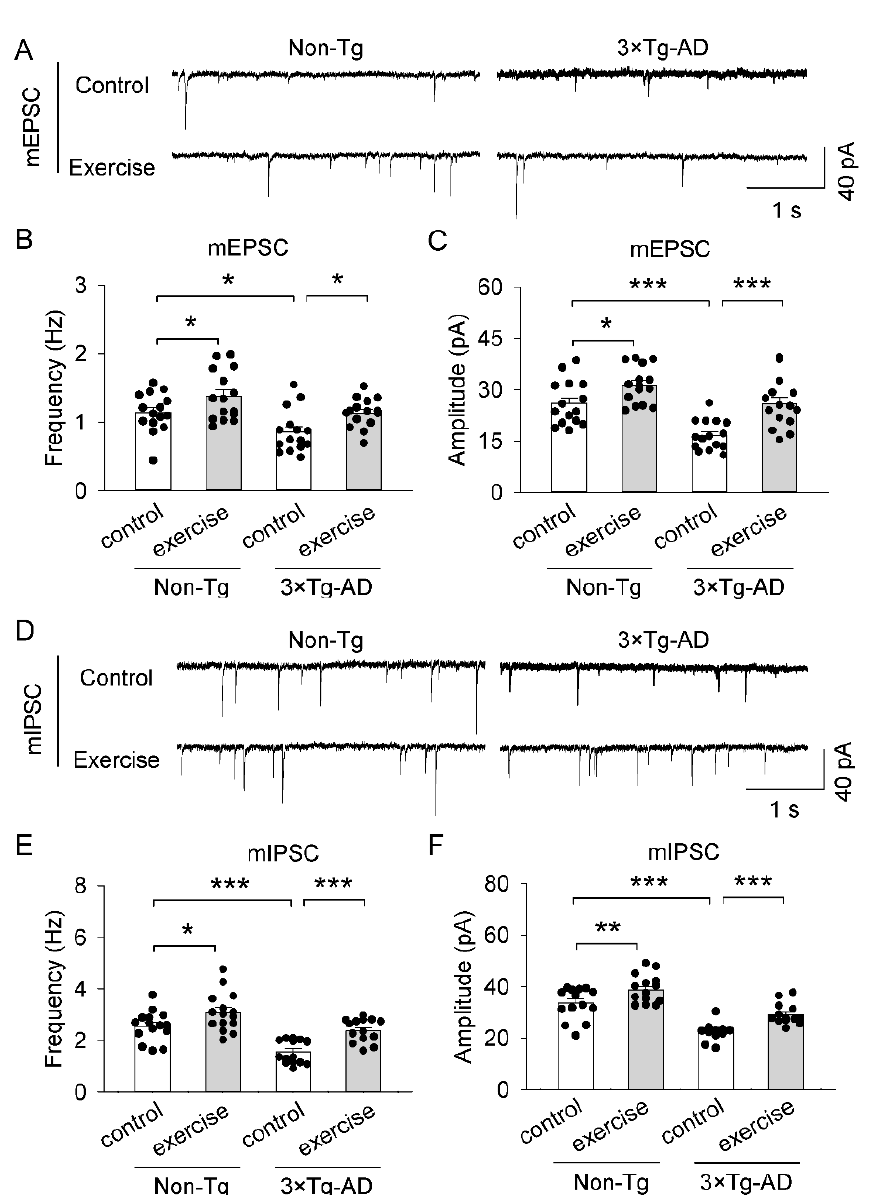
Figure 5. Treadmill exercise blocked the reduction of synaptic transmission of 3 × Tg-AD Mice. ( A , D ) Representative mEPSCs ( A ) and mIPSCs ( D ) were recorded from prefrontal cortex pyramidal neurons in slices prepared from the non-Tg control group, non-Tg exercise group, 3 × Tg-AD control group, 3 × Tg-AD exercise group mice. ( B , C ) The mean frequency ( B ) and amplitude ( C ) of mEPSCs in the prefrontal cortex in these four groups of mice. The mean frequency (* p = 0.014, n = 15-15 and amplitude (*** p < 0.001, n = 15-15) of mEPSCs were significantly decreased in the 3 × Tg-AD mice compared to the non-Tg control group, and these decreases were attenuated by treadmill exercise pretreatment (frequency, * p = 0.012, n = 15-15; amplitude, *** p < 0.001, n = 15-15). ( E , F ) The mean frequency ( E ) and amplitude ( F ) of mIPSCs in the prefrontal cortex in these four groups of mice. The mean frequency and amplitude of mIPSCs were significantly decreased in the 3 × Tg-AD mice com- pared to the non-Tg control group (*** p < 0.001, n = 15-15), and these decreases were attenuated by treadmill exercise pretreatment (*** p < 0.001, n = 15-15). Treadmill exercise increased the mean fre- quency (* p = 0.012, n = 15-15) and amplitude of mIPSC (** p = 0.007, n = 15-15) in non-Tg mice. Each data set was obtained from 6 mice.